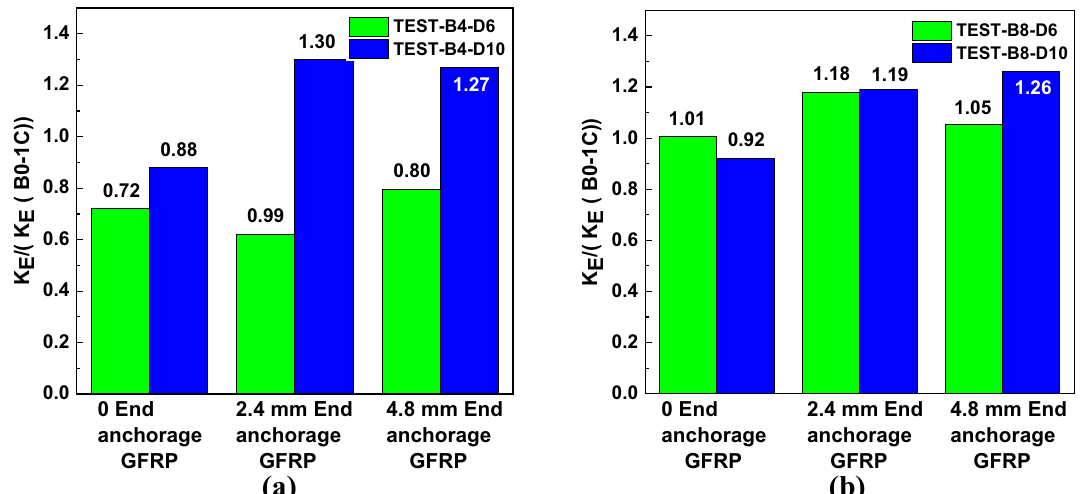
Fig. 10 Normalized elastic stiffness versus bolt diameter and end anchorage thickness